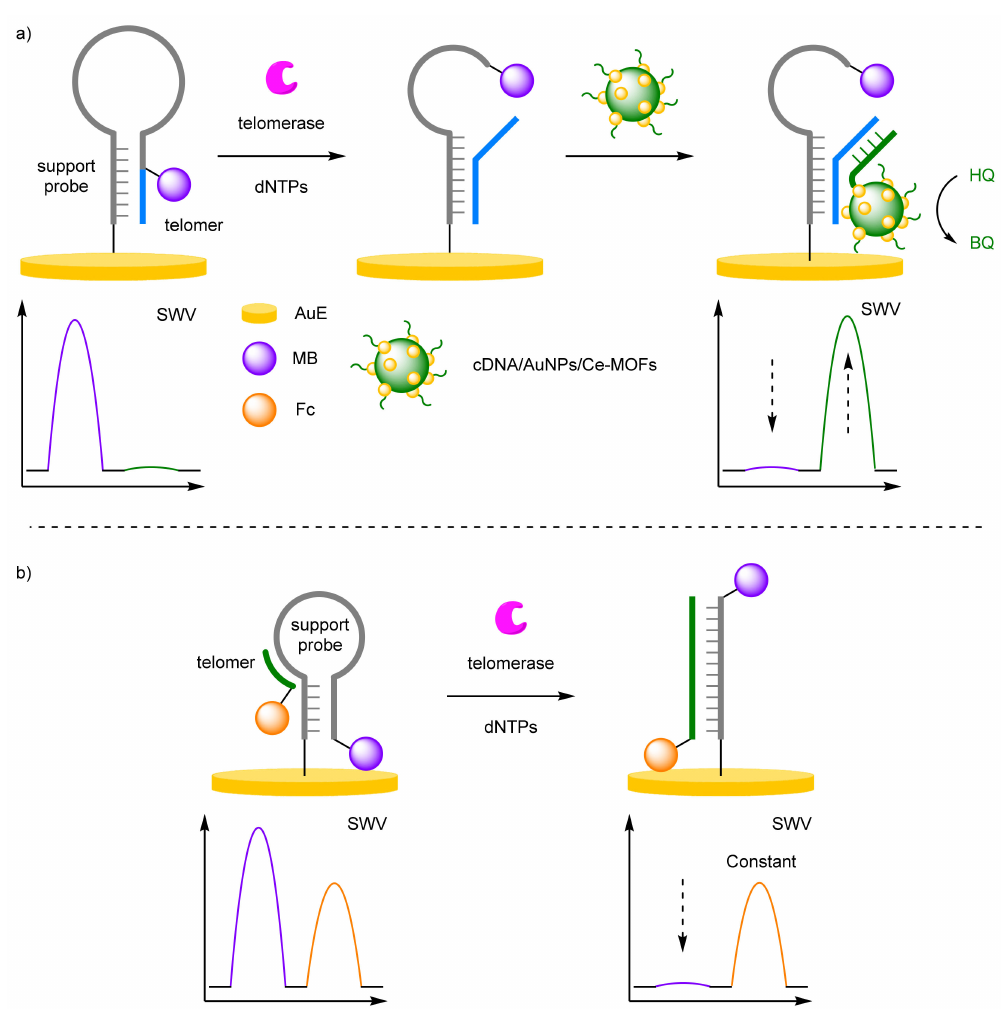
Figure 9. Schematic representation of two biosensor for the detection of telomerase: ( a ) a MOF based approach; ( b ) a hybridisation